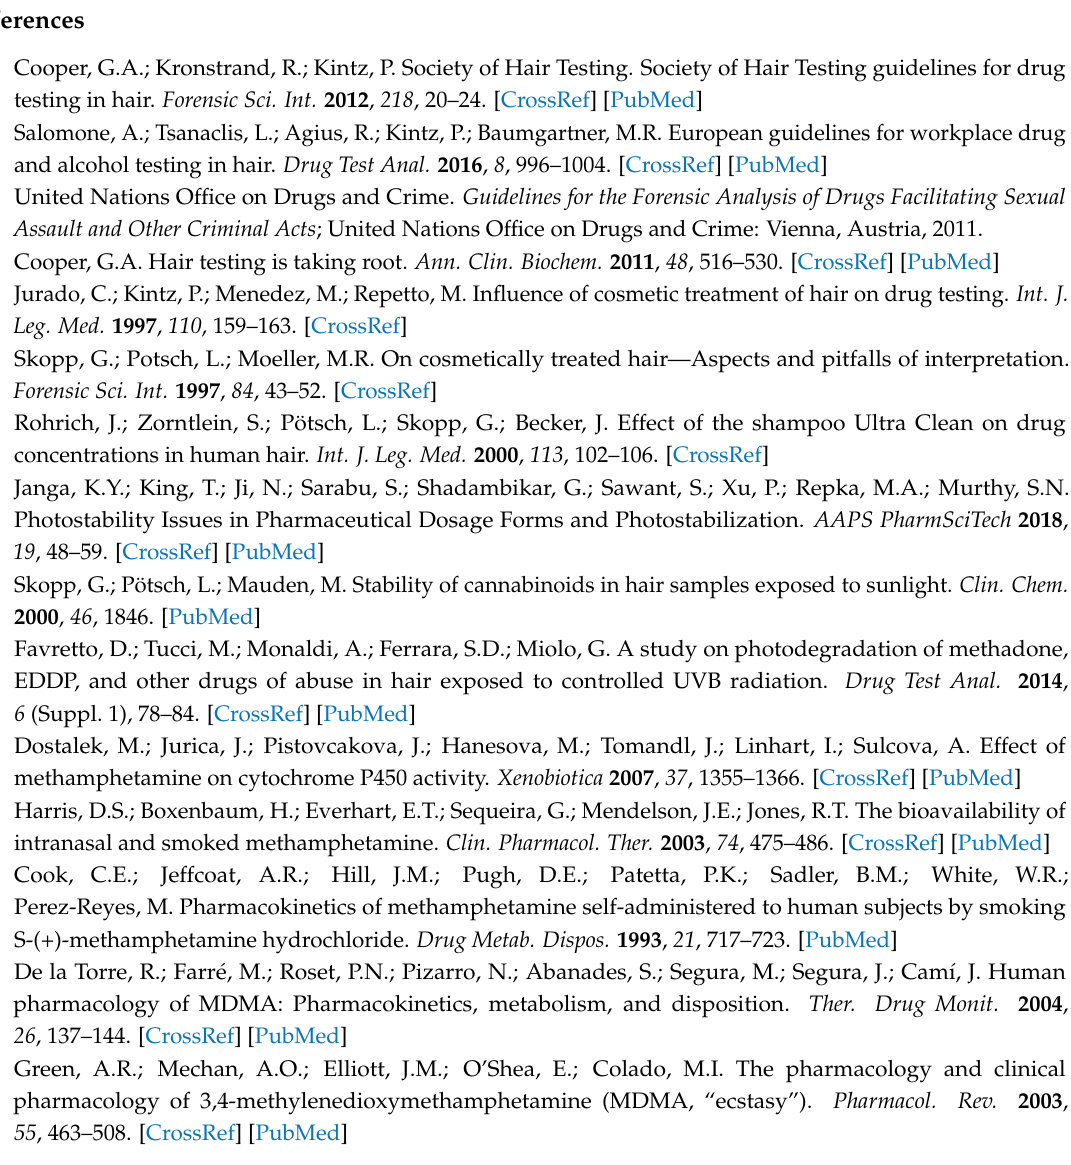
Fig S1A1/A2. UV spectrum of AMF (10-4 M) in methanol/water, by increasing exposure time in solar simulator; Fig S1B1/B2. UV spectrum of MA (10-4 M) in methanol/water, by increasing exposure time in solar simulator; Fig S1C1/C2. UV spectrum of MDA (10-4 M) in methanol/water, by increasing exposure time in solar simulator; Fig S1D1/D2. UV spectrum of MDMA (10-4 M) in methanol/water, by increasing exposure time in solar simulator; Fig S1E1/E2. UV spectrum of KET (10-4 M) in methanol/water by increasing exposure time in solar simulator; Fig S1F1/F2. UV spectrum of NKET (10-4 M) in methanol/water, by increasing exposure time in solar